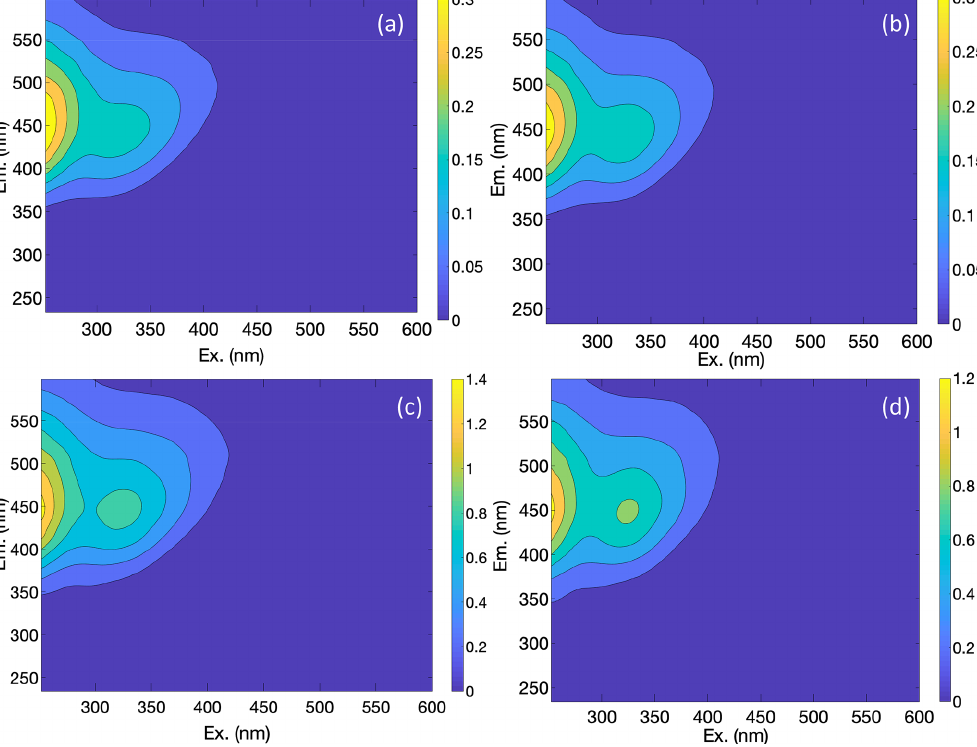
Figure A5. EEMs of filtered source water samples compared to reconstituted solid-phase extracts. (a) Large wetland, with source water. (b) Small wetland, with source water. (c) Large wetland, with solid-phase extract. (d) Small wetland, with solid-phase extract. Figure shows samples originally collected on 5 October